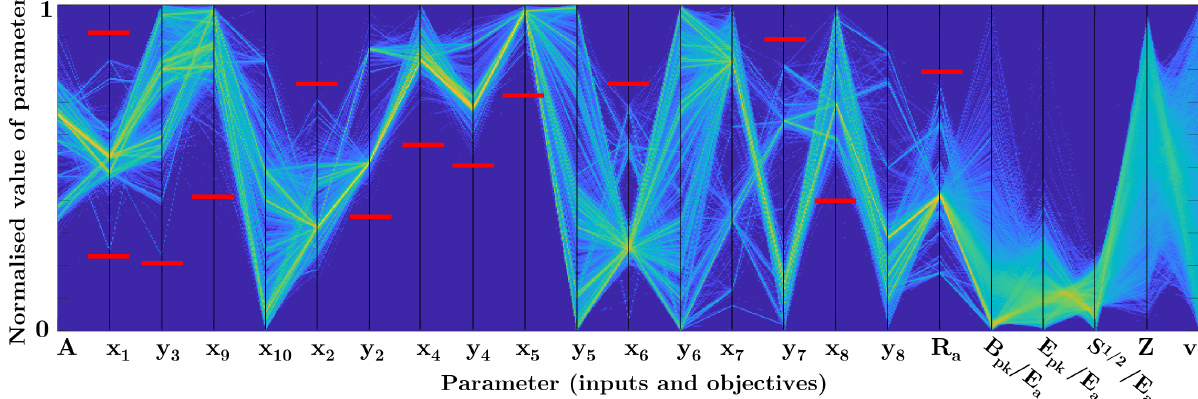
FIG. 18. Density PCP for X-band traveling wave cavity, showing input and output spaces. The density of the lines represents the number of solutions in a certain region, and red lines show where initial input space constraints could potentially be reduced for improved convergence speed [35].